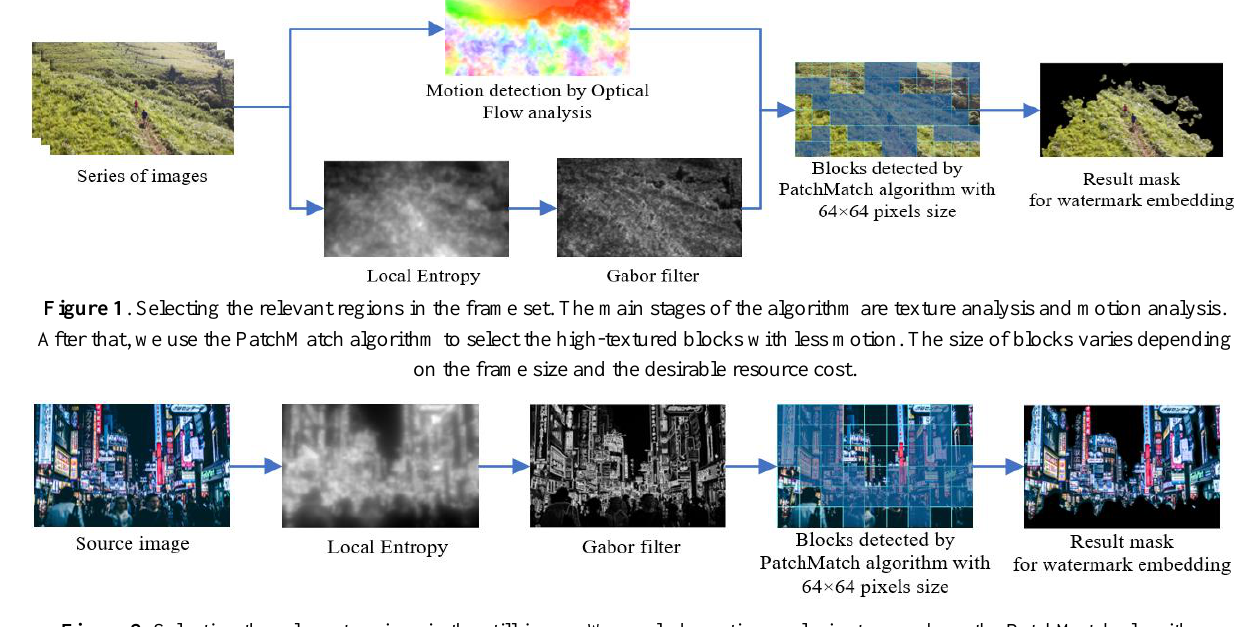
Figure 2 . Selecting the relevant regions in the still image. We exclude motion analysis stage and use the PatchMatch algorithm mainly to select the high-textured